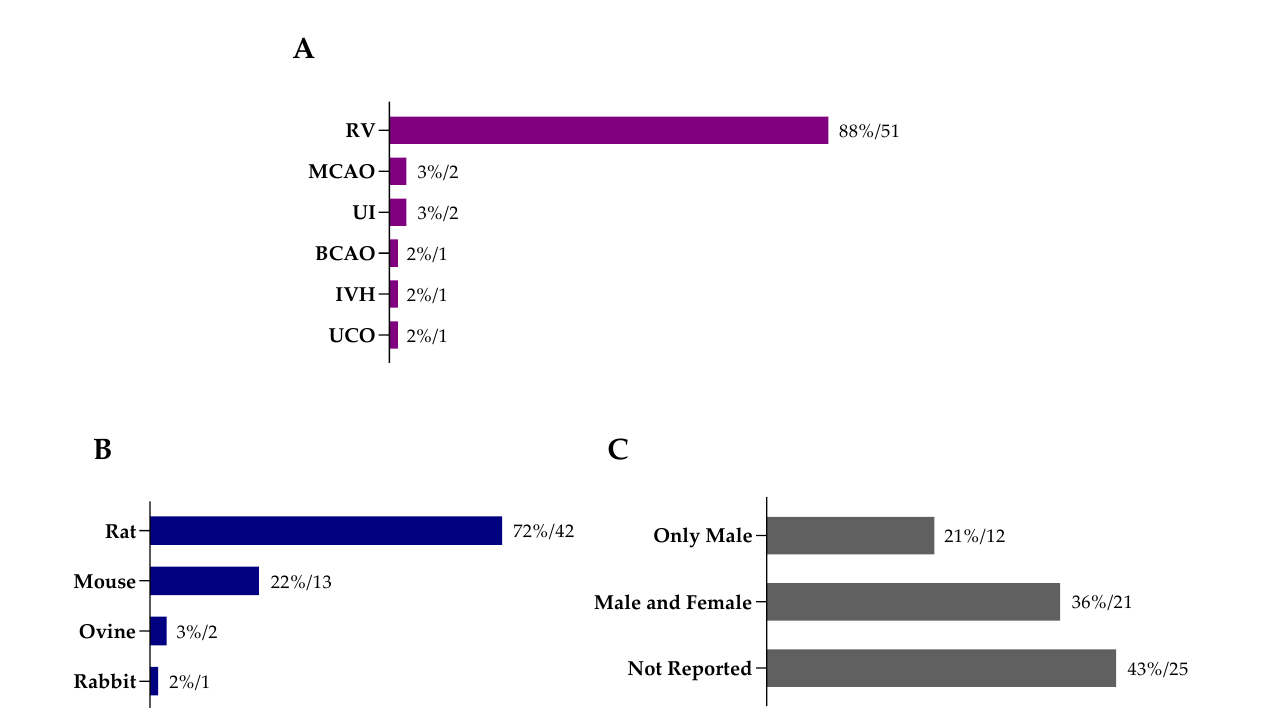
Figure 2. ( A ) Animal models used to induce hypoxic-ischemic encephalopathy in the studies included in this systematic review, as well as the employed ( B ) species and ( C ) animals’ sex across the different studies (percentage/number of reports). Abbreviations: BCAO—bilateral carotid artery occlusion; IVH—intraventricular hemorrhage; RV—Rice–Vannucci animal model (or adaptation); MCAO—middle cerebral artery occlusion; UCO—umbilical cord occlusion; UI—uterine ischemia.